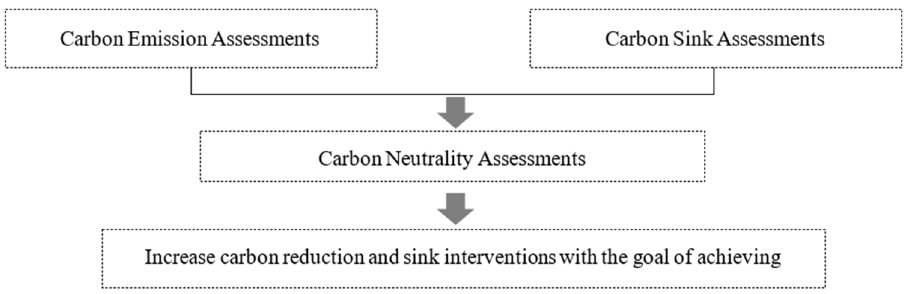
Figure 4. Carbon Evaluation and Intervention Theory Mode.